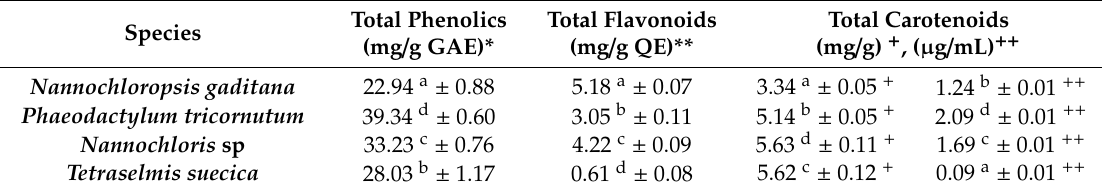
Table 1. Total phenolics, flavonoids, and carotenoids in the four microalgae under study.